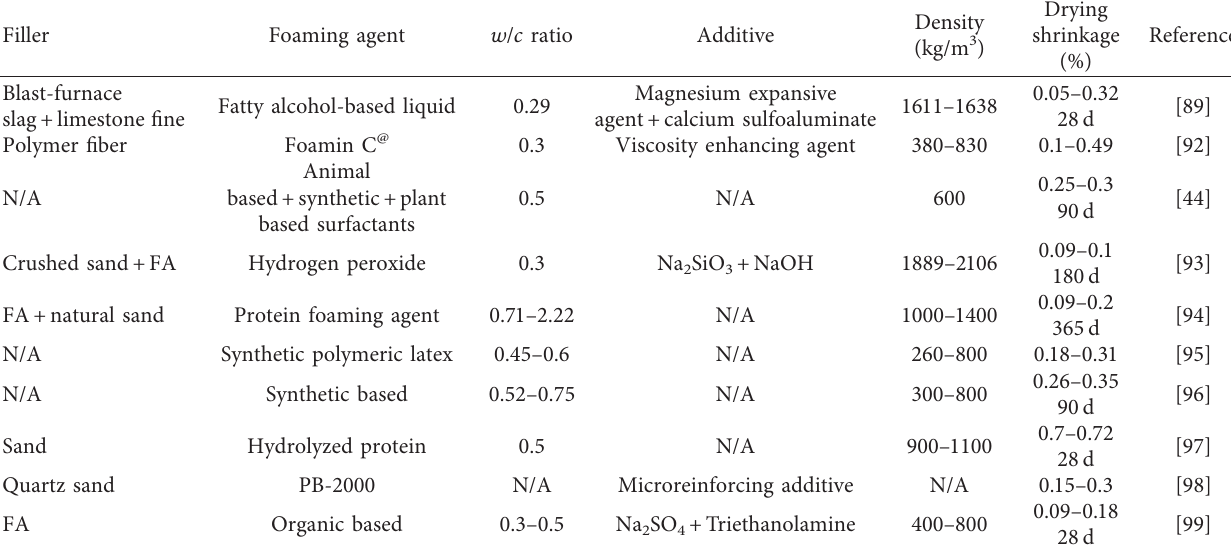
Table 2: Review of filler, foaming agent, and additive used in FC, and the resulting density ranges and drying